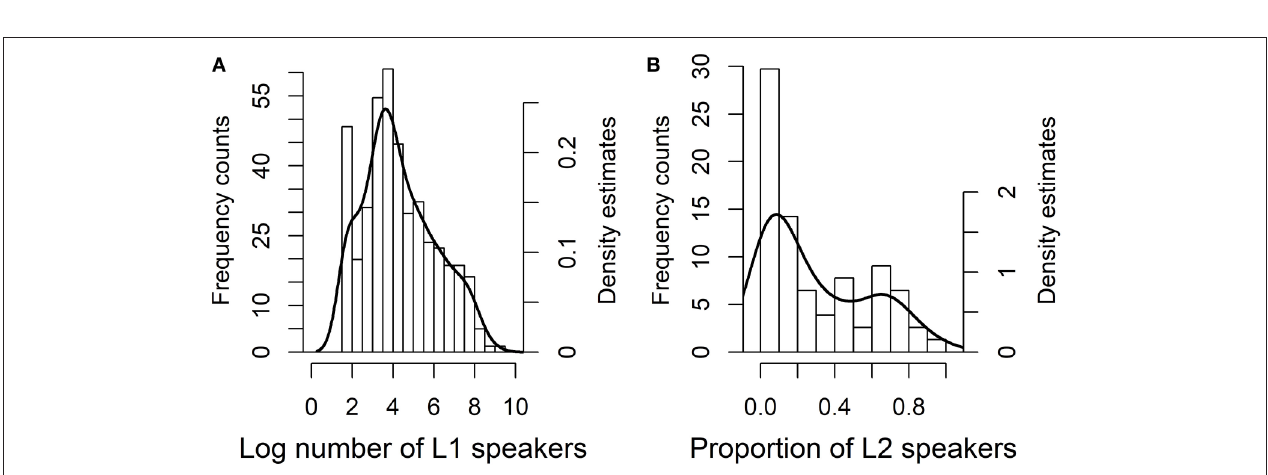
FIGURE 10 | The distribution of number of genders on a world map (In the figure black dots represent languages with no gender and blue dots represent those with two genders. The deeper the red color, the more genders the language has).